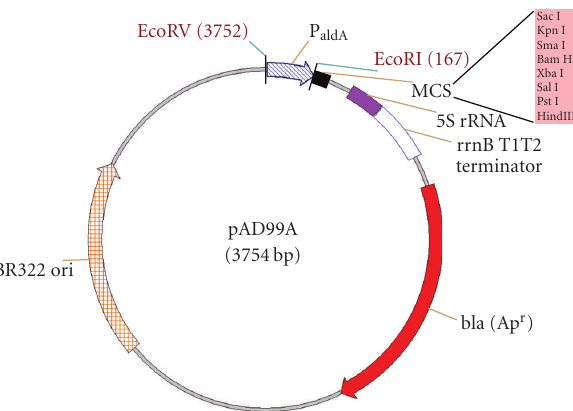
Figure 4: Map of plasmid pAD99A. Its characteristics include pBR322 ori, origin of replication of pBR322; bla , ampicillin- resistance gene; P aldA , aldA promoter; a target gene to be inserted in multiple cloning sites